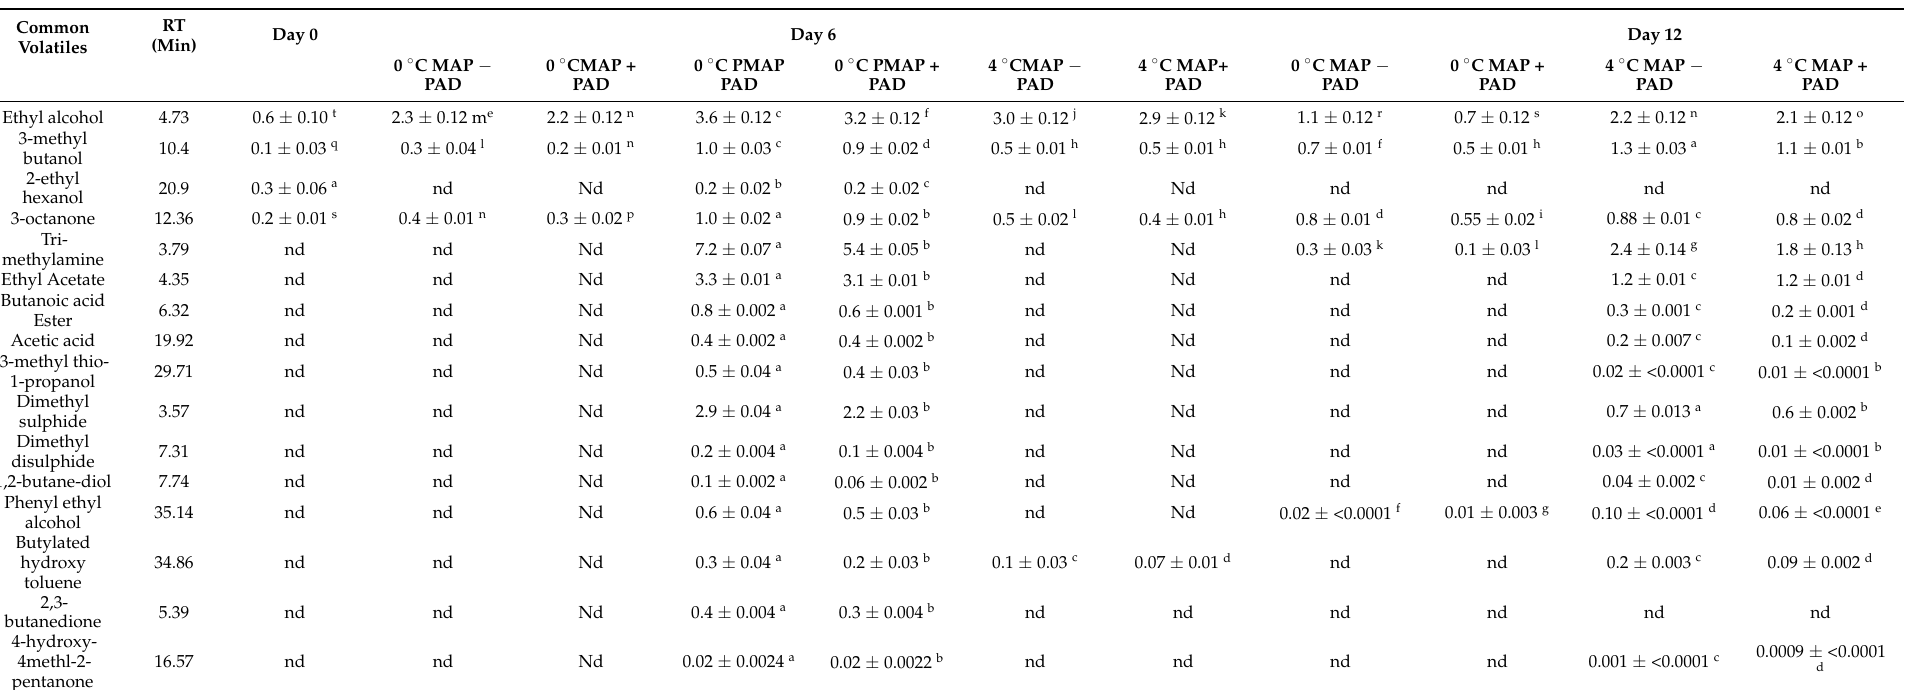
Table 3. Common volatiles identified from MA-packaged Cape hake fillets using gas chromatography–mass spectra analysis showing freshness and spoilage indicator markers expressed as % peak areas indicating sampling days 0, 6 and